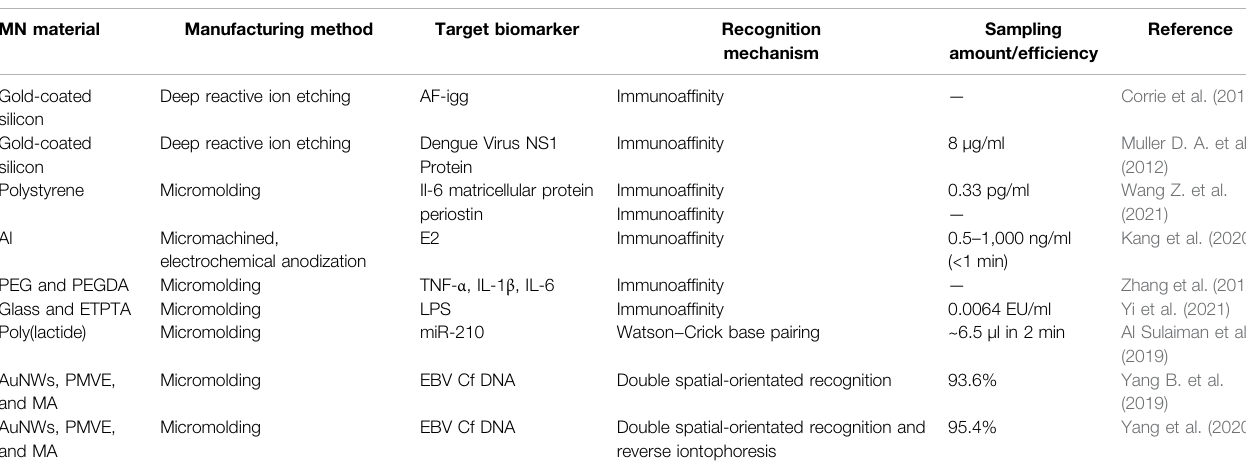
TABLE 2 | Properties of MNs for biomarker